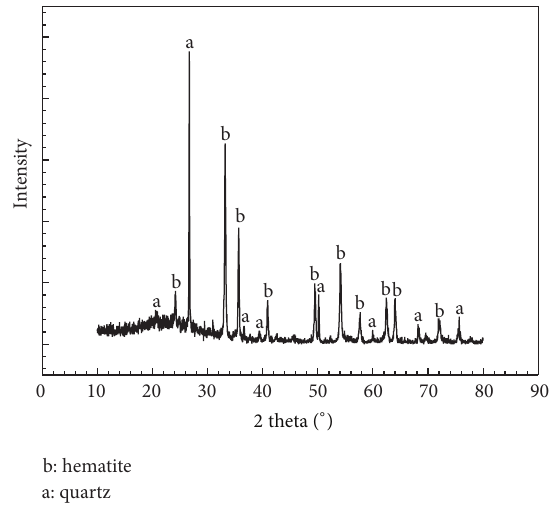
Figure 2: XRD pattern of the raw hematite